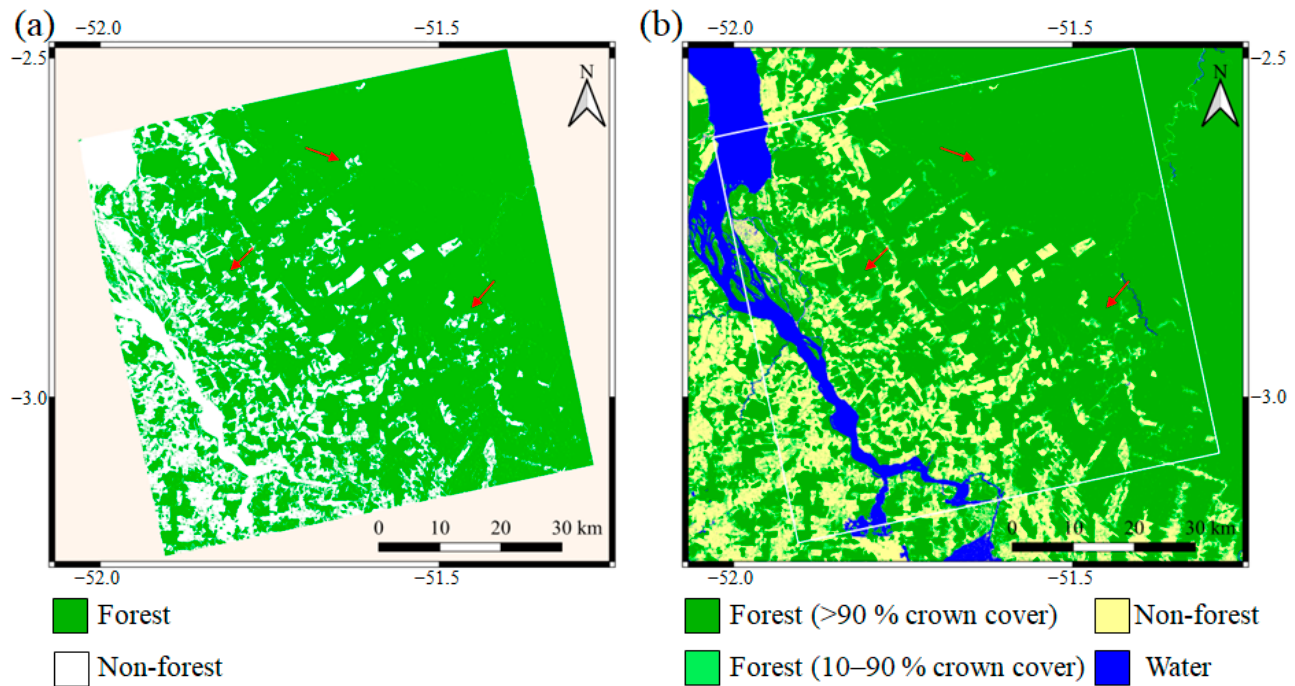
Figure 7. Forest map of Altamira using the proposed method with actual dual-polarization data acquired on 4 April 2019. ( a ) Forest map generated by the proposed method. ( b ) JAXA Global PALSAR-2 Forest/Non-Forest map in 2018. The white rectangle shows the observation area of dual-polarization data. The red arrows indicate deforestation in 2019 as visually confirmed by Planet/Dove mosaic images.